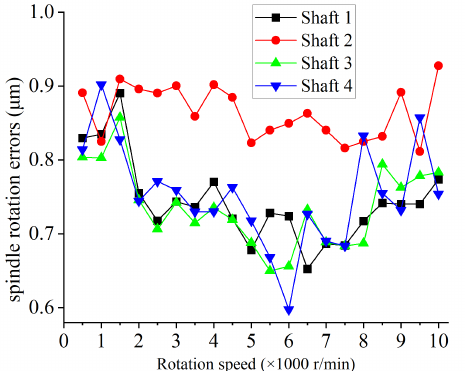
Figure 11. Spindle radial rotation errors of four